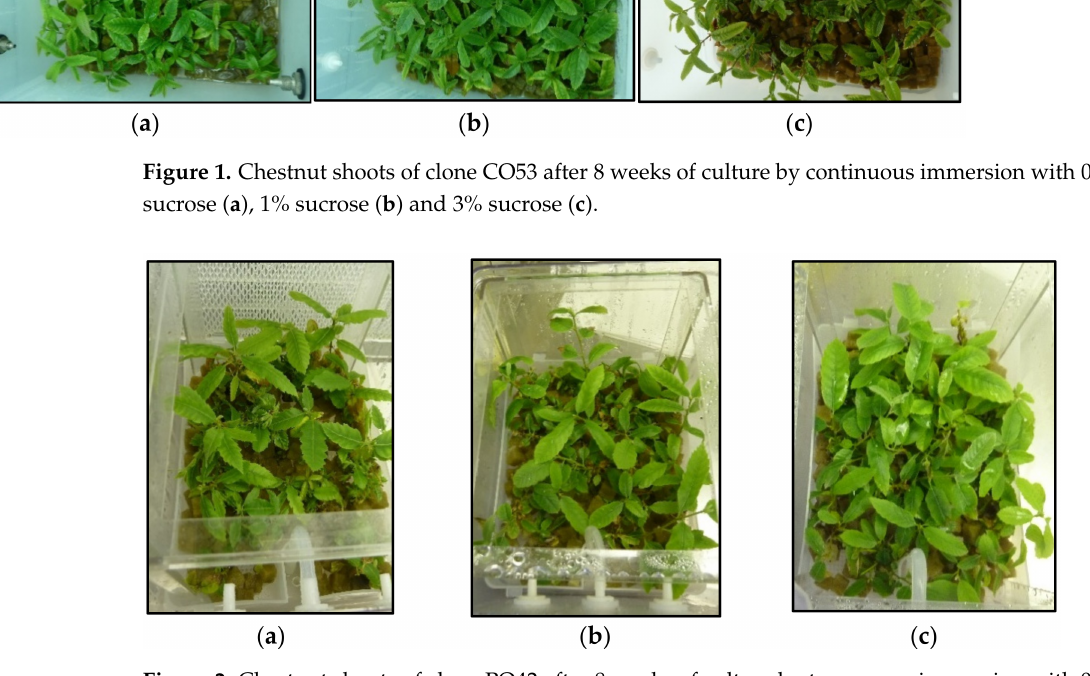
Figure 2. Chestnut shoots of clone PO42 after 8 weeks of culture by temporary immersion with 0.5% sucrose ( a ), 1% sucrose ( b ) and 3% sucrose ( c